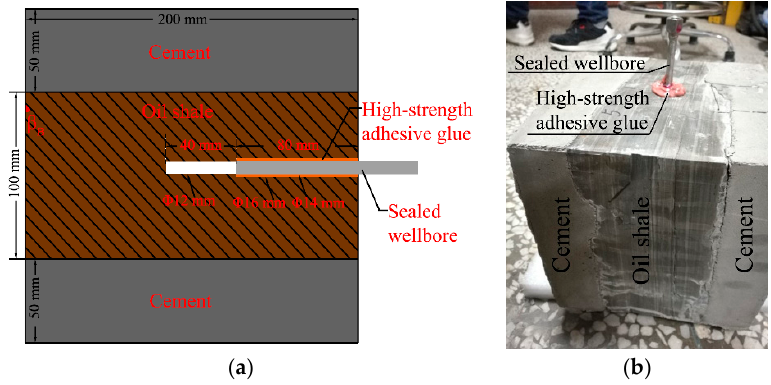
Figure 12. Samples of oil shale with ( a ) schematic diagram and ( b ) real